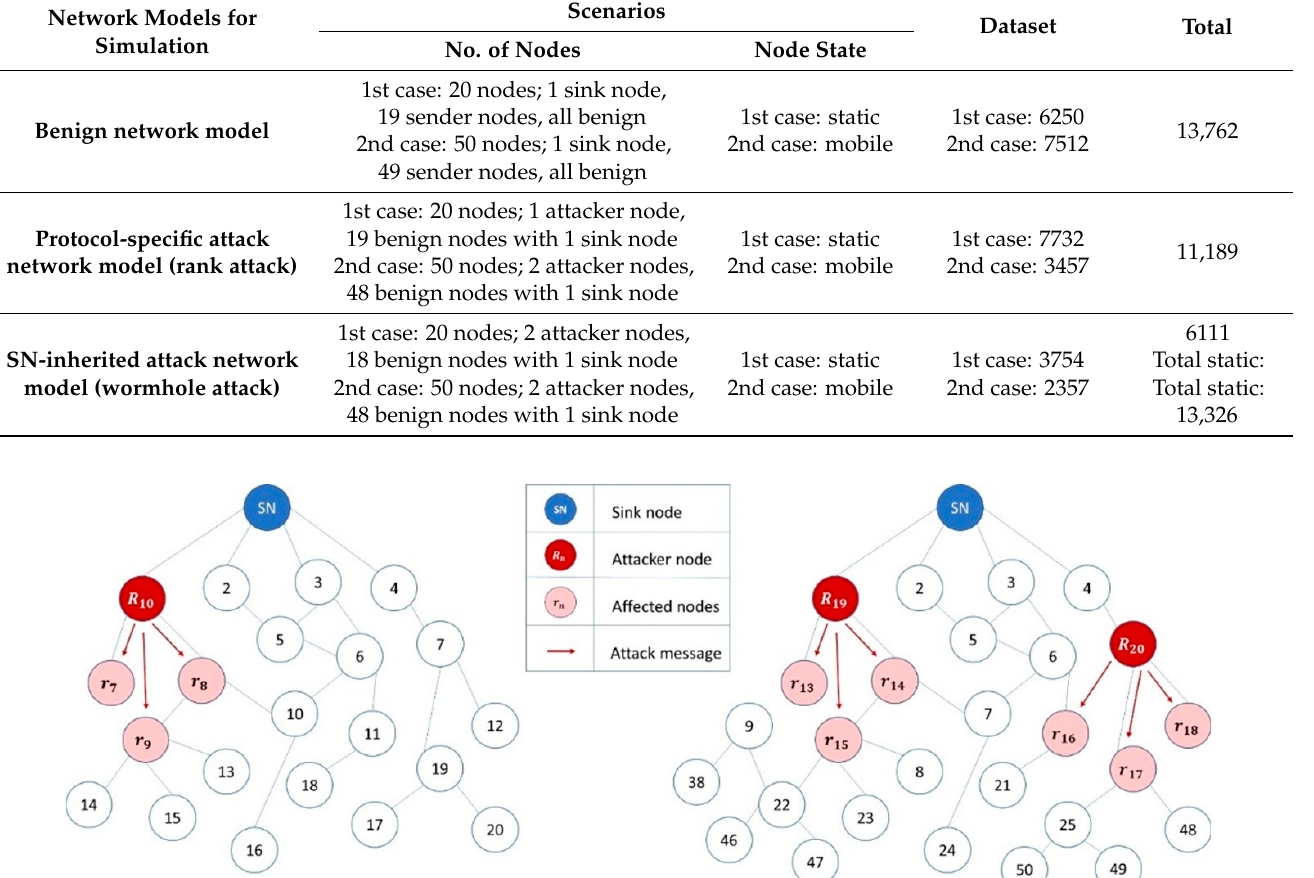
Table 2. The datasets from different network models and scenarios.